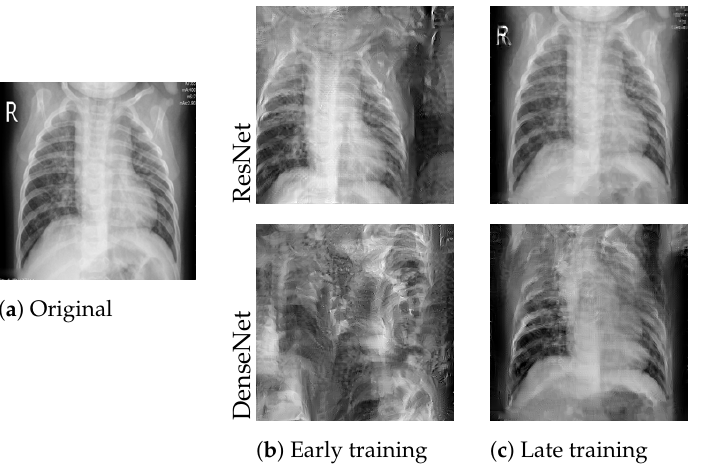
Figure 3. Best reconstructions of the image shown in ( a ) after the first ( b ) and after the fourth ( c ) communication round. Reconstruction quality increased significantly after several rounds of